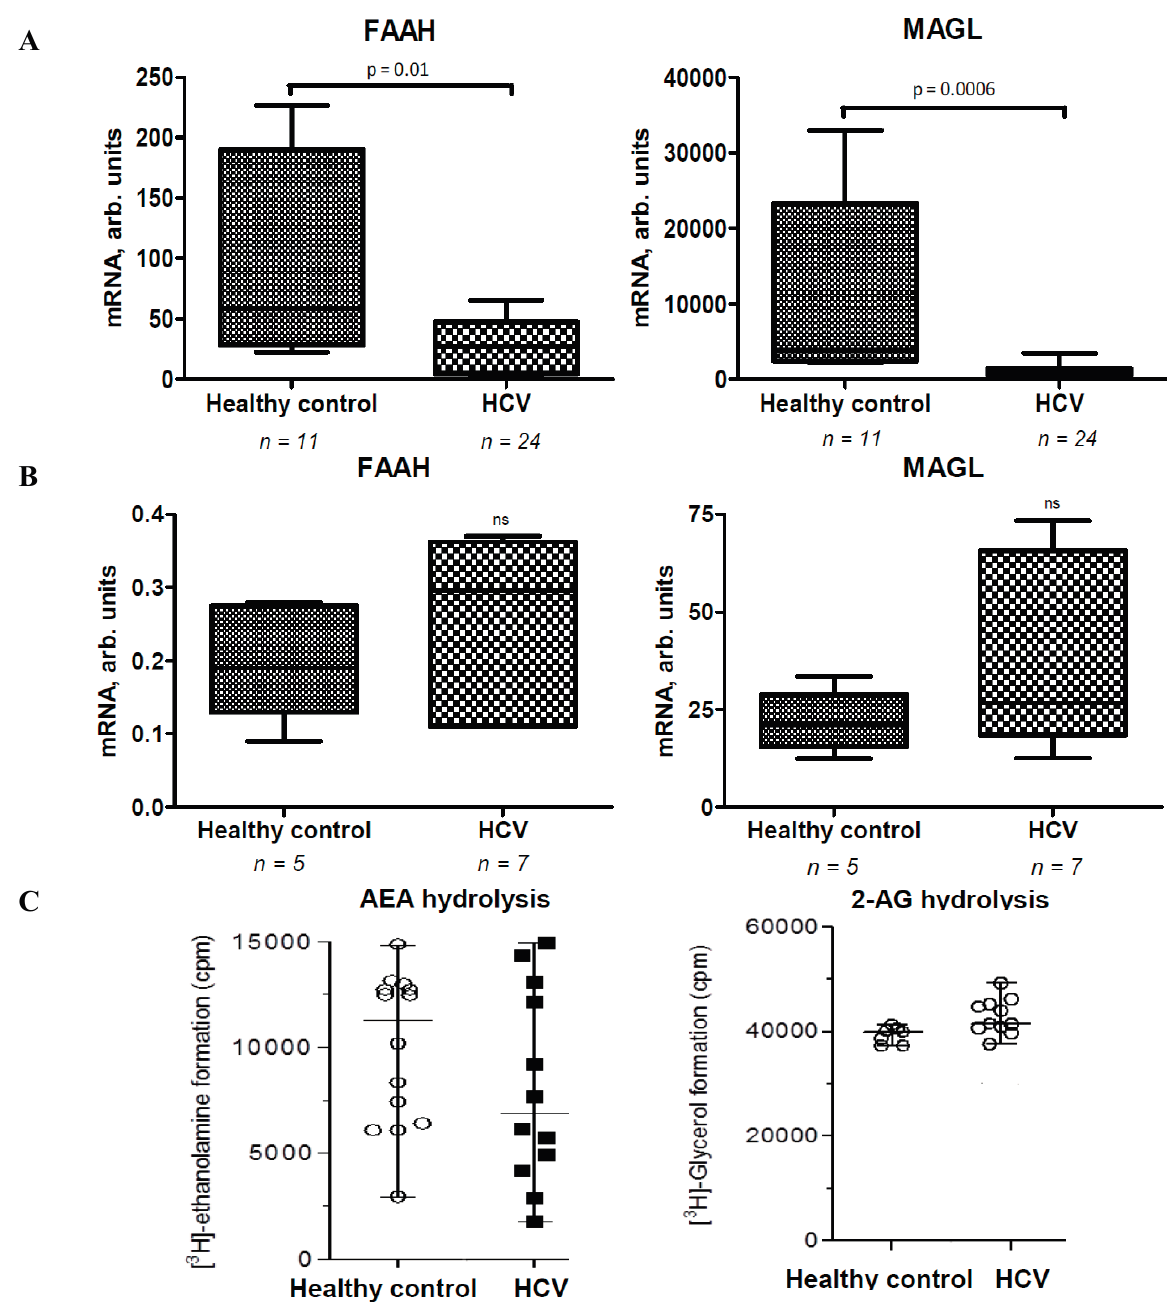
Figure 2. Fatty acid amide hydrolase (FAAH) and monoaclyglycerol lipase (MAGL) mRNA and activity in CHC patients and healthy controls. ( A ) FAAH mRNA and MAGL mRNA in liver biopsies from CHC patients and control livers; ( B ) FAAH mRNA and MAGL mRNA in PBMC from CHC patients and healthy controls; ( C ) FAAH and MAGL enzymatic activity in liver biopsies from CHC patients and control livers. ns—not